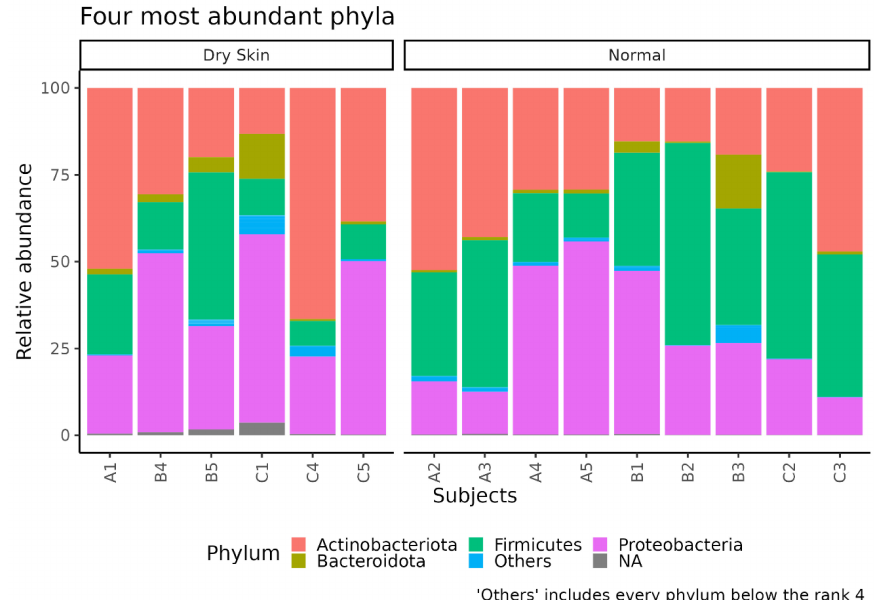
Figure 8. Taxonomic composition of facial skin samples in dry skin and normal skin groups. The stacked bar plot shows the relative abundance of the four more abundant bacterial phyla in each sample. The “Others” group contains phyla with rank below five.